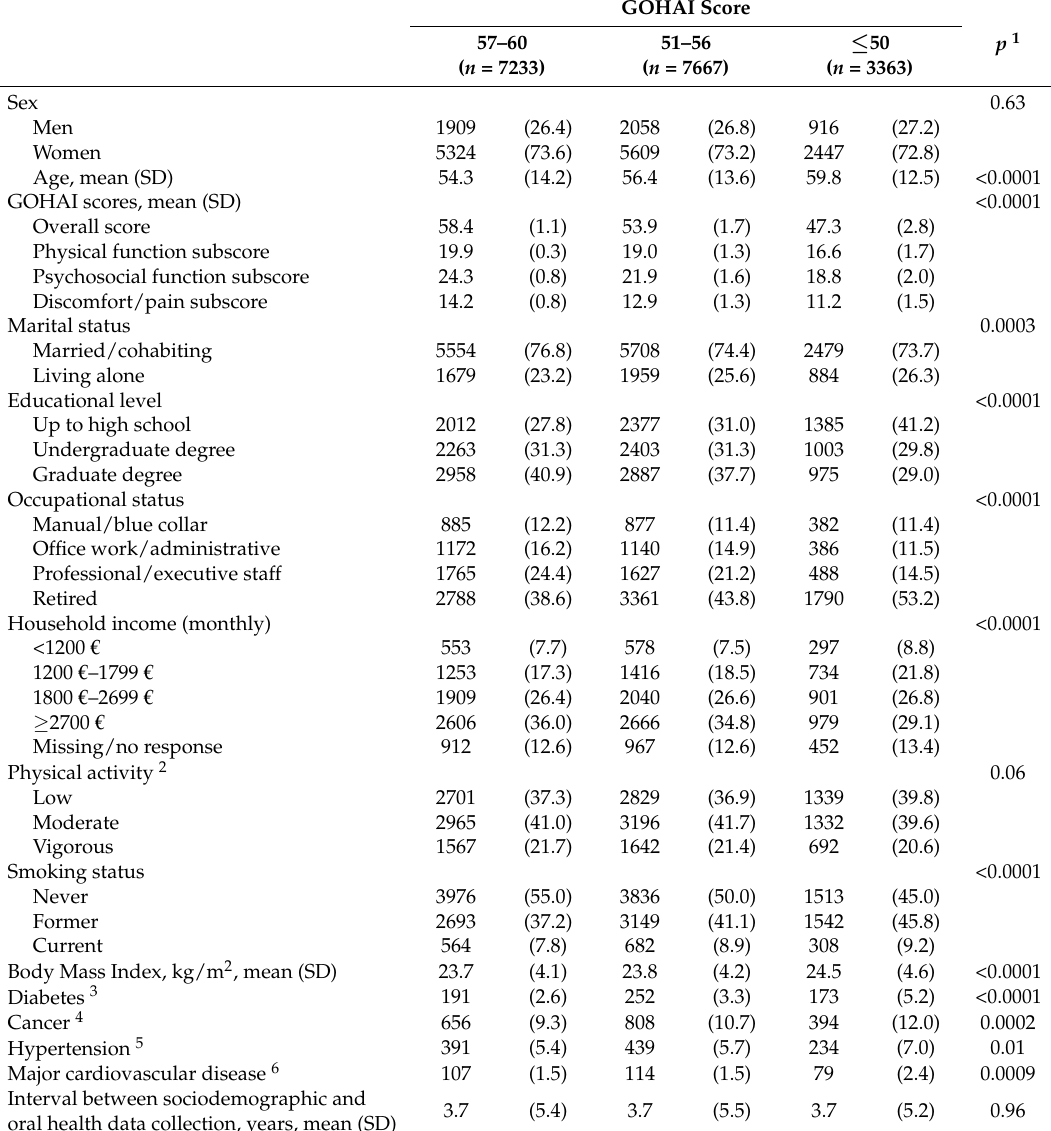
Table 1. Descriptive characteristics of study participants by overall GOHAI score (Etude NutriNet-Sant é , N =